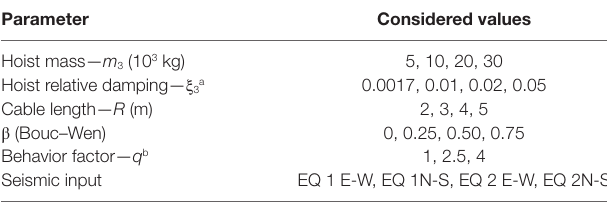
TaBle 1 | Considered parameters and range of